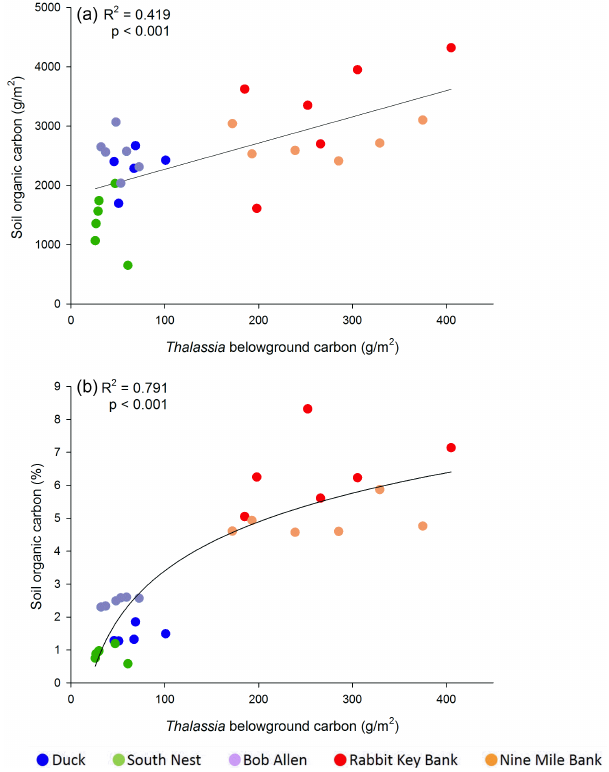
Figure 6. Relationship between Thalassia testudinum belowground carbon stock and soil carbon stock in control plots, reported in (a) gm − 2 (linear) and (b) percent (logarithmic). Sites are listed in the legend in order from east (most P limited) to west (least P lim-